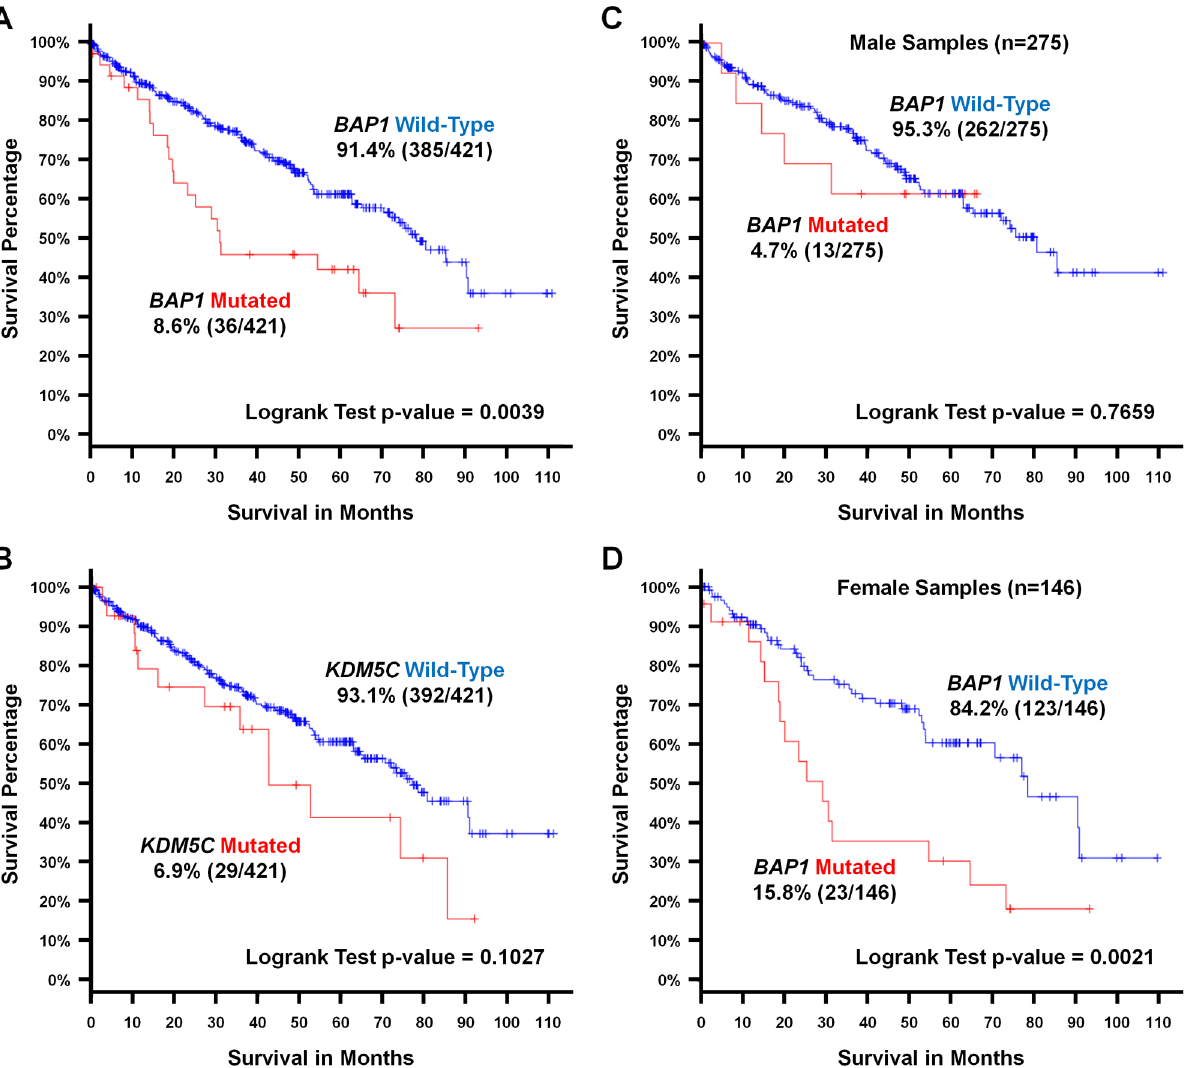
Fig 3. Mutation and Gender Specific Survival Analysis. (A and B) Kaplan-Meier survival analysis graphs were produced comparing samples with or within mutation of either BAP1 or KDM5C for CCRCC TCGA cohort and (C and D) comparing the differences in survival with or without mutation of BAP1 for each gender. Analysis was performed using the cBioPortal software (http://www.cbioportal.org/index.do) [6,7] and mutated samples were represented by red lines and wild-type samples by blue lines. Survival data was available for 421 samples within the CCRCC TCGA cohort consisting of 275 males and 146 females. p-values less than 0.01 were considered statistically